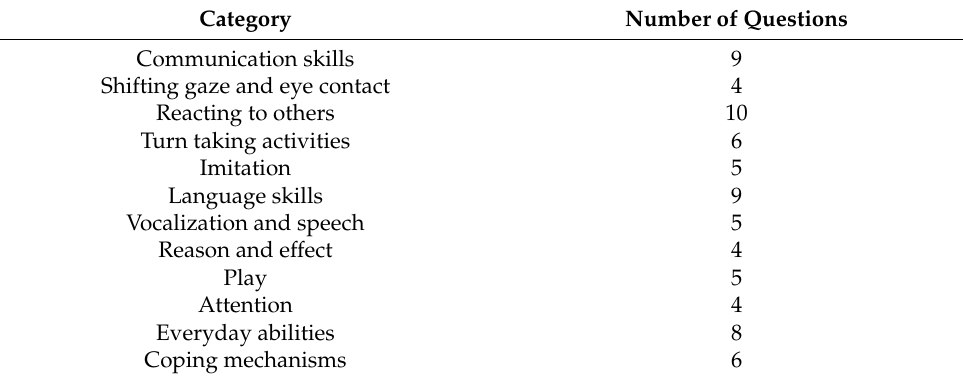
Table 3. Categories and number of questions per